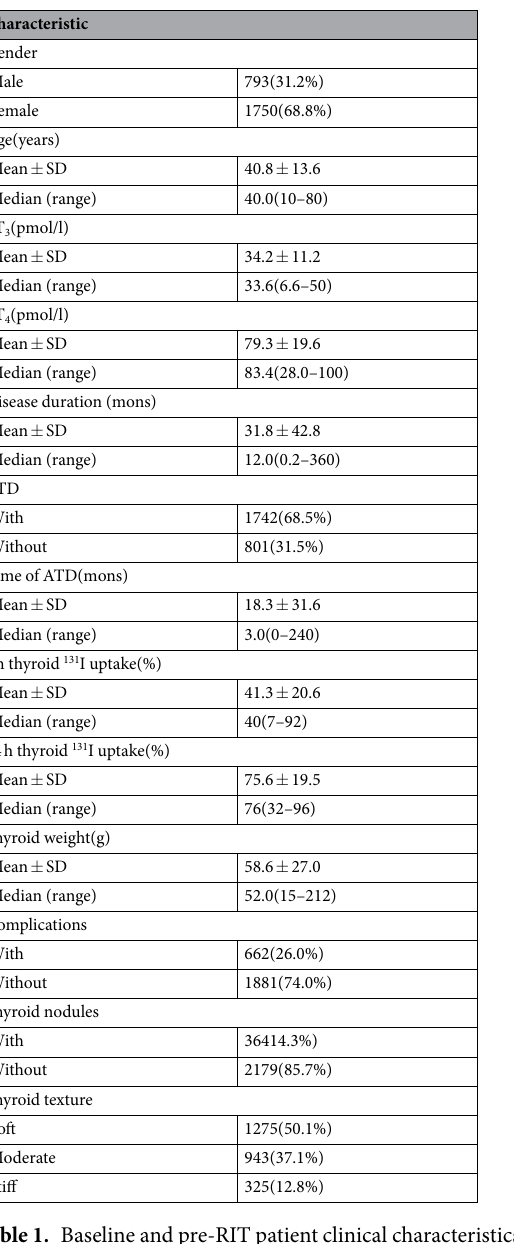
Table 1. Baseline and pre-RIT patient clinical characteristics (n = 2543). Data are presented as count (percentage) or mean ± SD and median (range). RAIU = radioiodine uptake, FT 3 = free triiodothyronine, FT 4 = free thyroxine, SD = standard deviation, ATD = antithyroid